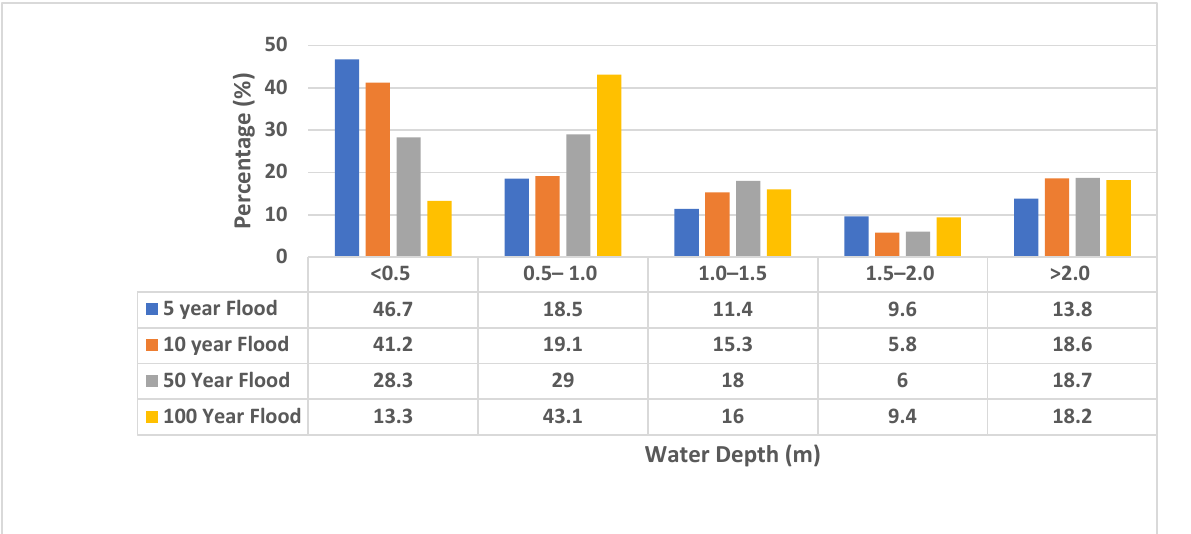
Figure 8. Return Period–Flood Depth Relationship.